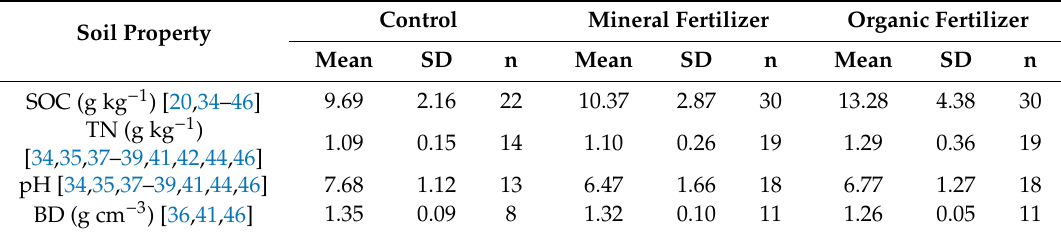
Table 2. E ff ect of chemical and organic fertilizers on soil